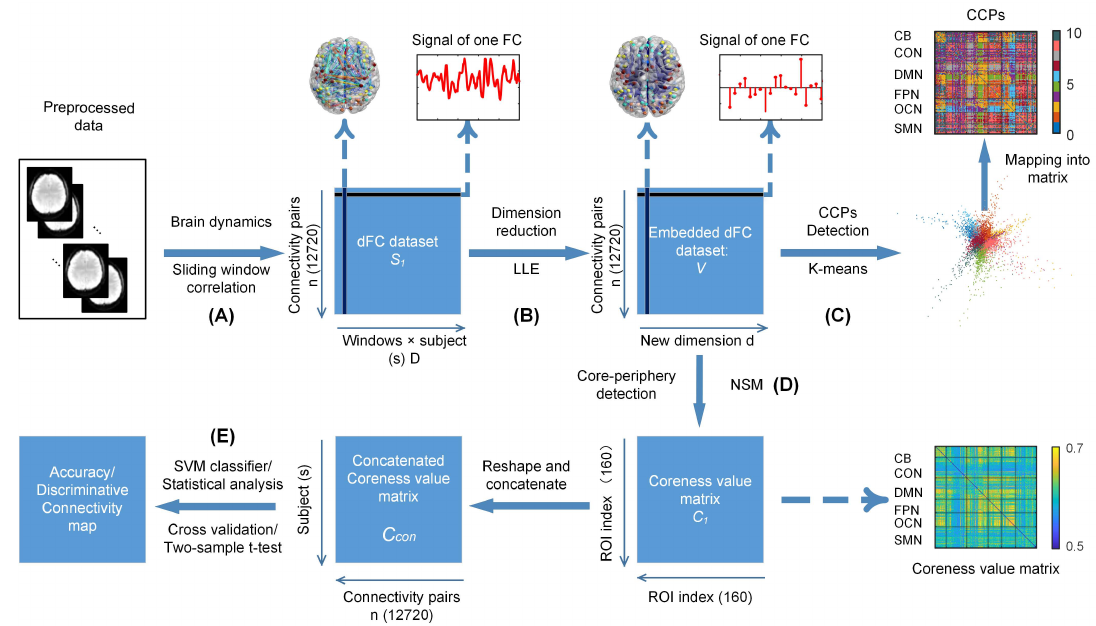
Figure 1. The framework of the manifold learning model. ( A ) Using the sliding-window correlation approach to estimate the dynamic functional connectivity for the participants. The obtained dFC dataset was rearranged into the matrix. The rows of the matrix are the sliding-window signals of the connectivity pairs. The columns of the matrix are all connectivity pairs ordered by the correlation sequence of the ROI atlas. ( B ) Embedding the dataset in a low-dimensional manifold space with the LLE algorithm. The columns of the embedded dFC dataset are mapped into d